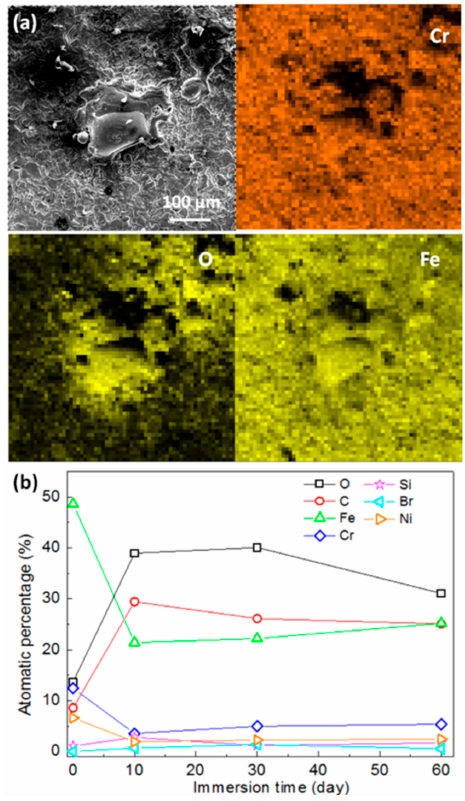
Figure 6. ( a ) EDS analysis of corroded 316L surface after 60 days’ immersion; ( b ) elementary composition of mechanically bonded 316L as a function of immersion time under atmospheric condition.